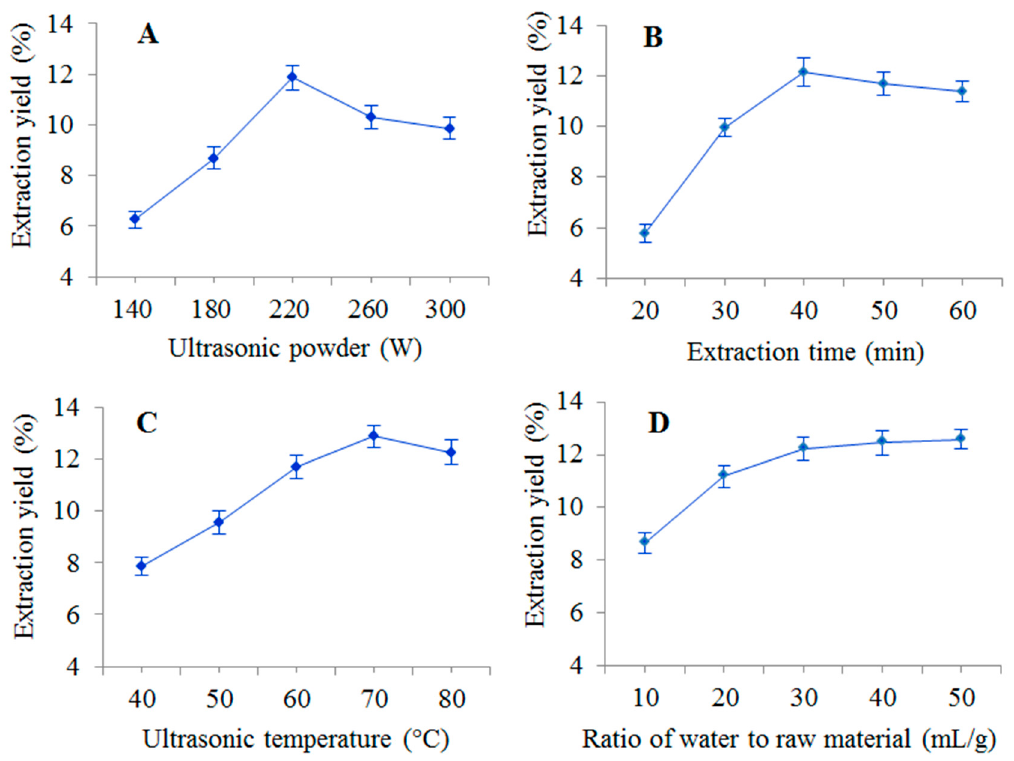
Figure 1. Effects of different extraction parameters ( A : ultrasonic power; B : extraction time; C : ultrasonic temperature; D : ratio of water to raw material) on the yield of PSA.